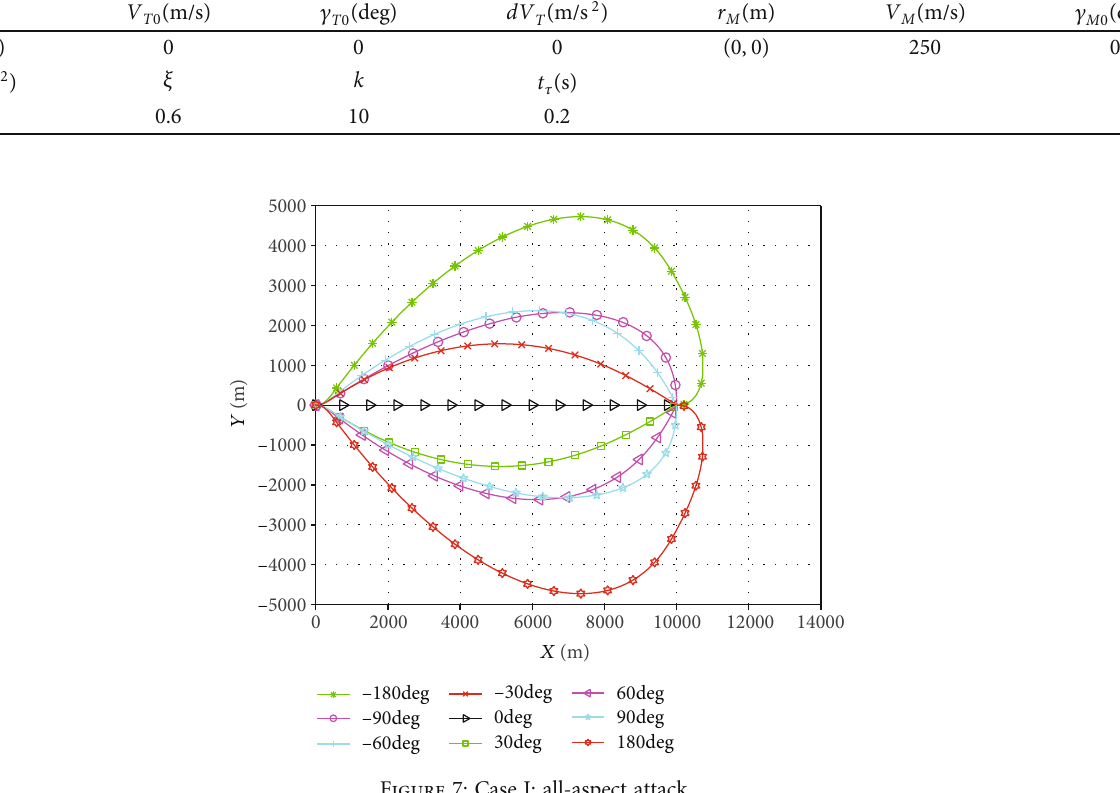
Figure 7: Case I: all-aspect